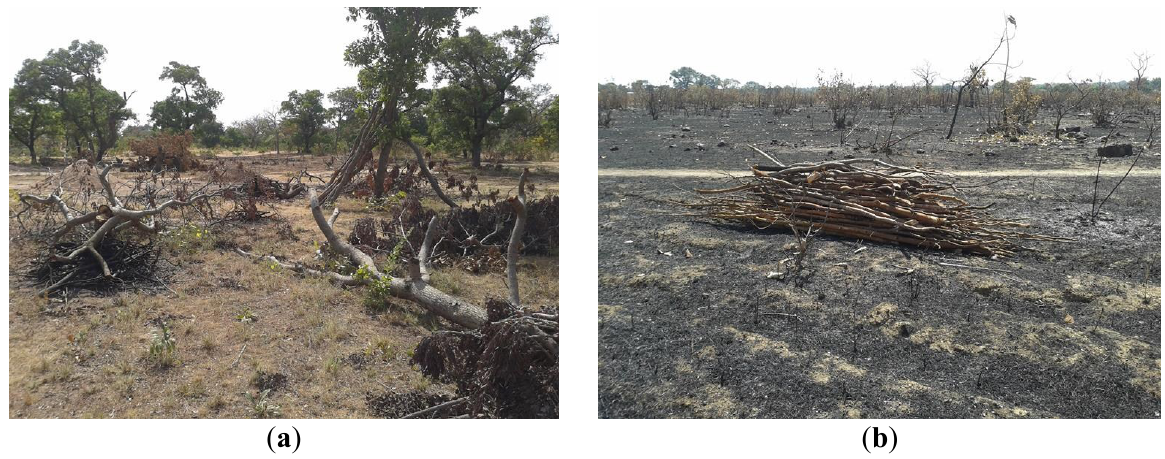
Figure 7. ( a) Trees cut for new cropland; and ( b ) fuel wood collected in an area devastated by